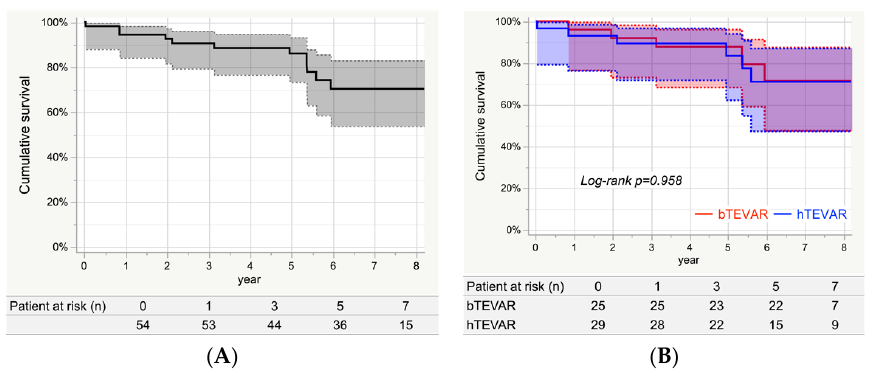
Figure 2. Cumulative survival. ( A ) Cumulative survival of the entire study group. The cumulative survival rates at 1, 3, 5, and 7 years were 94.4% (95% CI:84.1 – 98.2%), 90.6% (79.3 – 96.0%), 86.0% (73.3 – 93.2%), and 70.4% (53.7 – 83.0%), respectively. ( B ) Cumulative survival of each group. The 7-year survival rates in the bTEVAR group and the hTEVAR group were 71.5% (47.6 – 87.4%) and 71.0% p = 0.958).